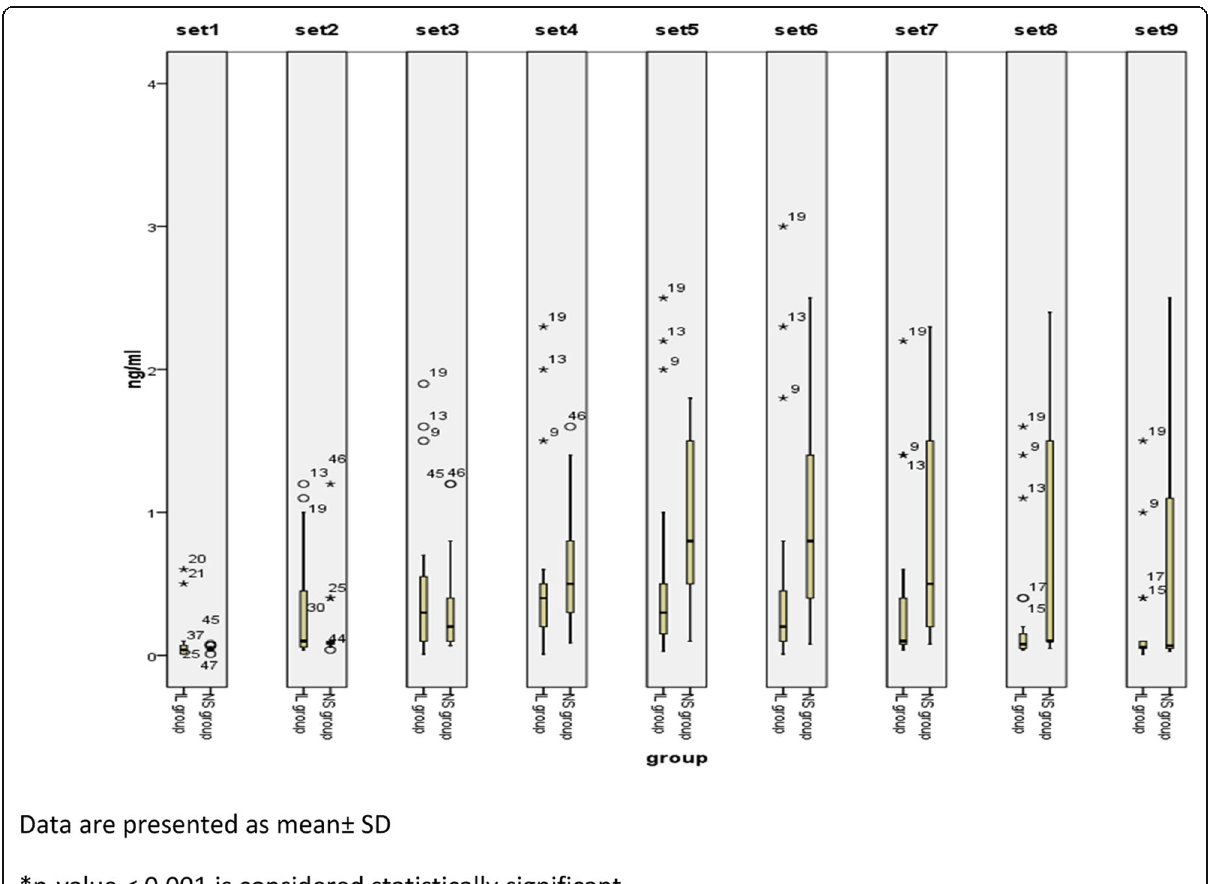
Fig. 2 Different sets of tropnin I taken every 6 h. The middle black solid line represents the median, the upper and lower margins of each box are the IQR, whiskers are maximum and minimum values, and dots and asterisks represent the number of patient with outlier